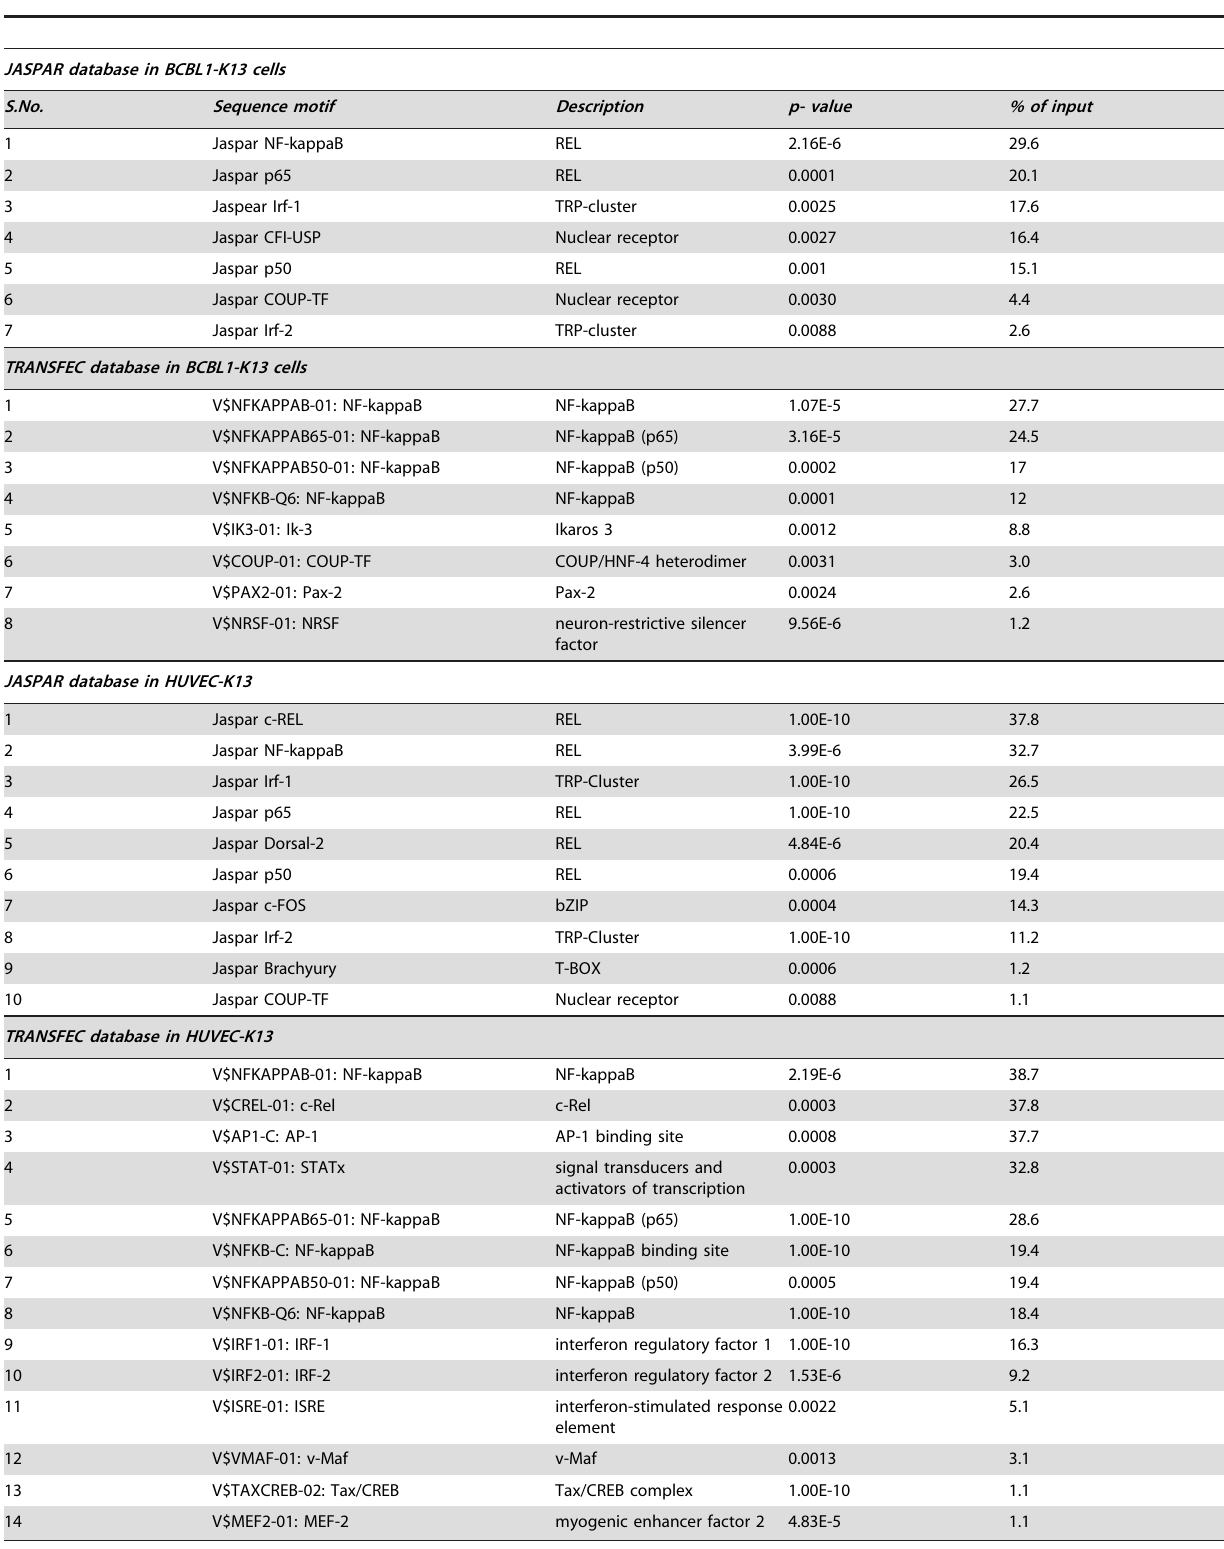
Table 3. Transcription factors with binding sites over-represented in promoters of genes upregulated by K13 in BCBL1 and